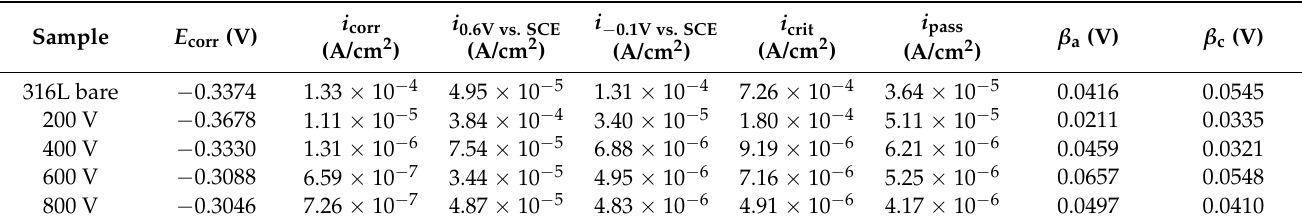
Figure 1. Potentiodynamic polarization curves of Nb-coated 316L samples in 0.5 M H 2 SO 4 at 70 °C with purged ( a ) air and ( b ) H 2 . Table 3. Corrosion parameters extracted from potentiodynamic polarization curves.